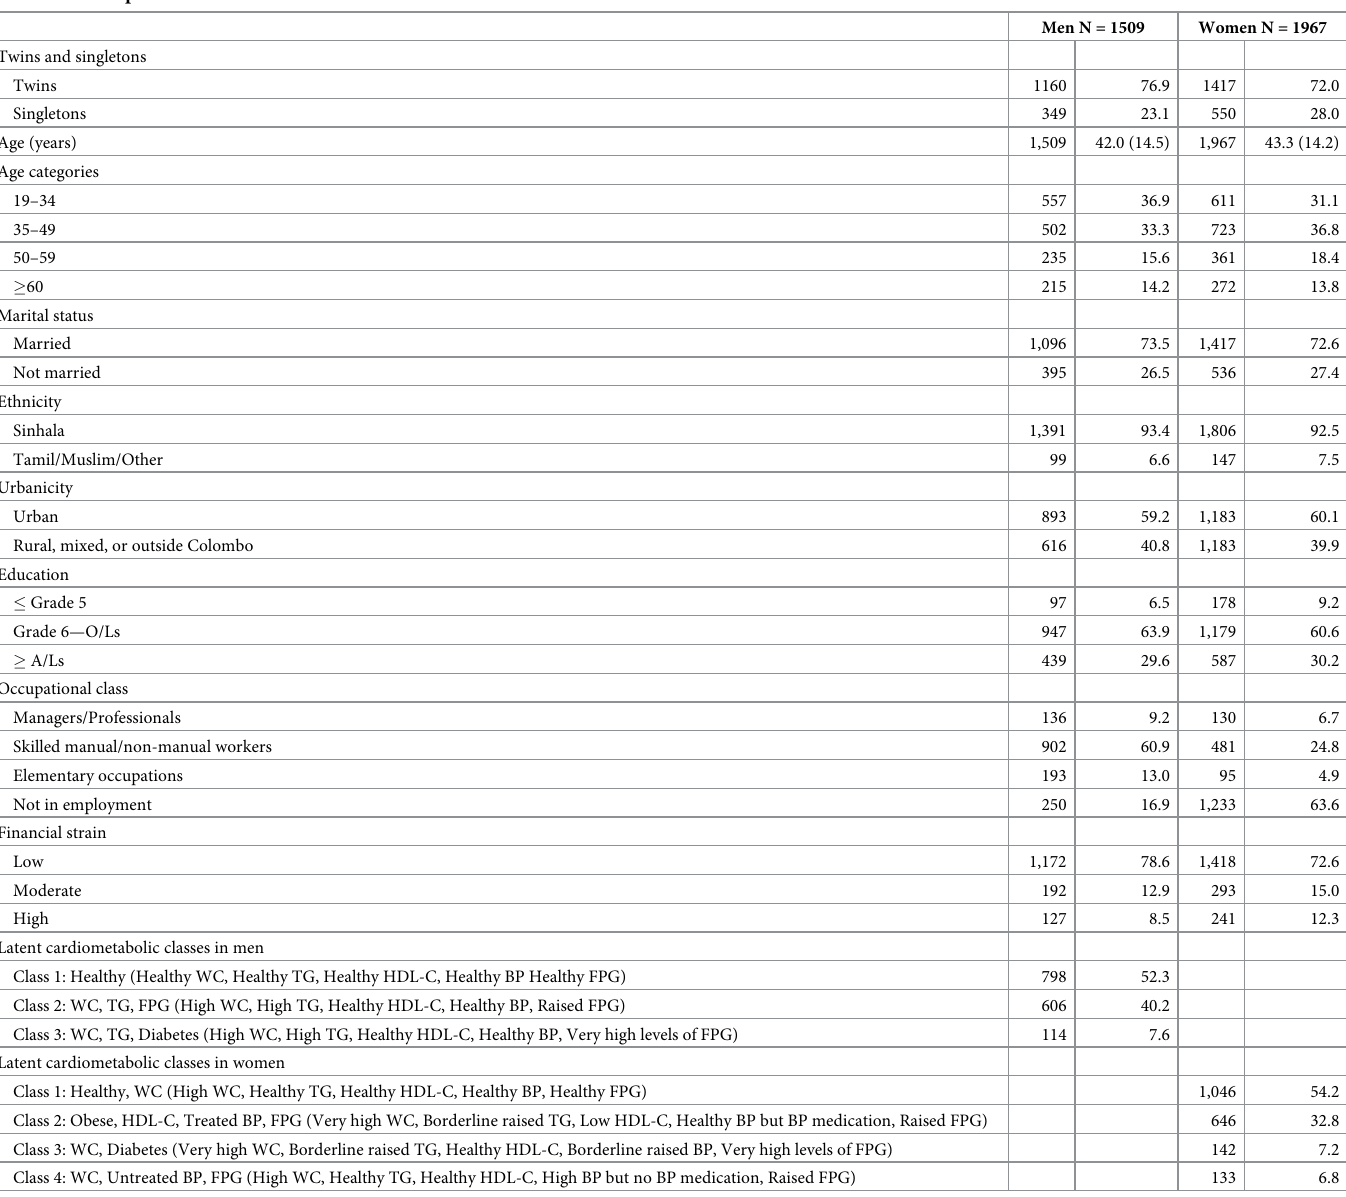
Table 1. Descriptive table and latent cardiometabolic